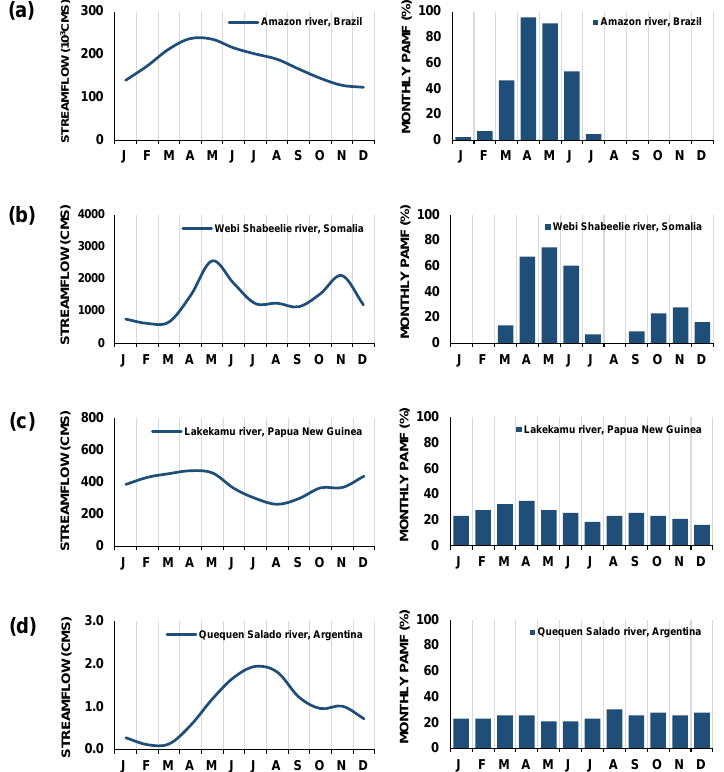
Figure 10. Model-based streamflow climatology (left panels) and corresponding monthly PAMF (right panels). Types and locations are (a) uni-modal streamflow – at Bom Lugar, Amazon River, Brazil, (b) bimodal streamflow – at Saacow, Webi Shabeelie River, Somalia, (c) constant streamflow – at Terapo Mission, Lakekamu River, Papua New Guinea, and (d) low flow – at La Sortija, Quequen Salado River,